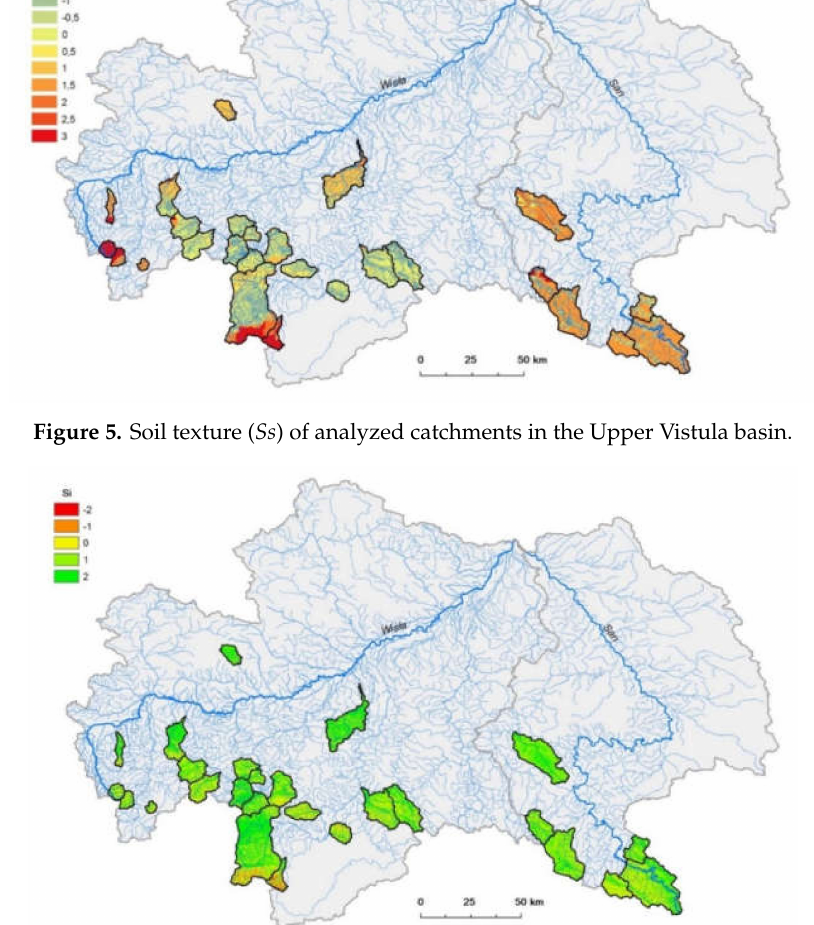
Figure 6. Slope inclination ( Si ) of analyzed catchments in the Upper Vistula